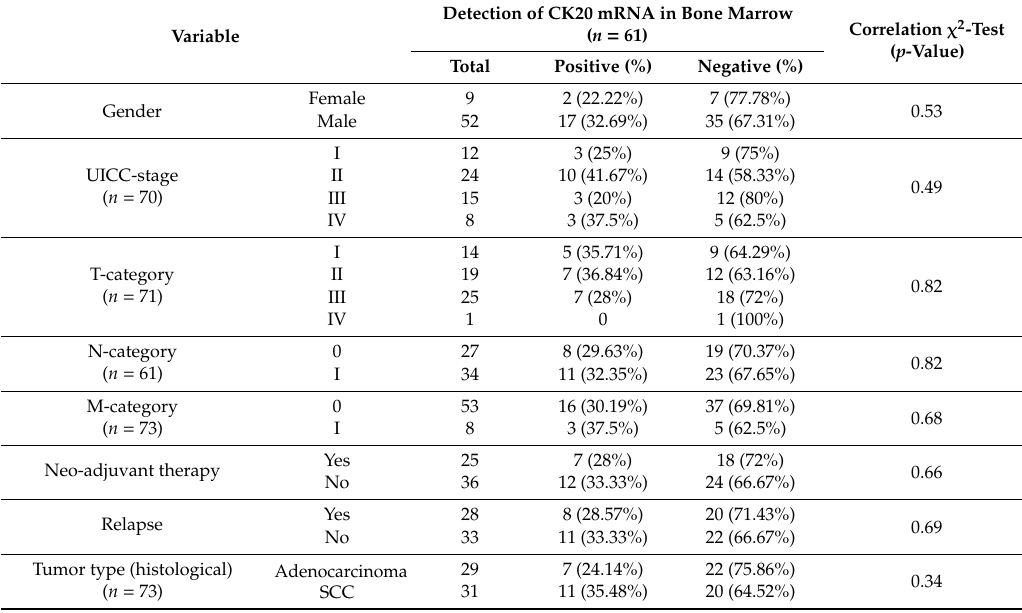
Table 4. Correlation between CK20 mRNA detection in bone marrow of esophageal carcinoma patients and clinical